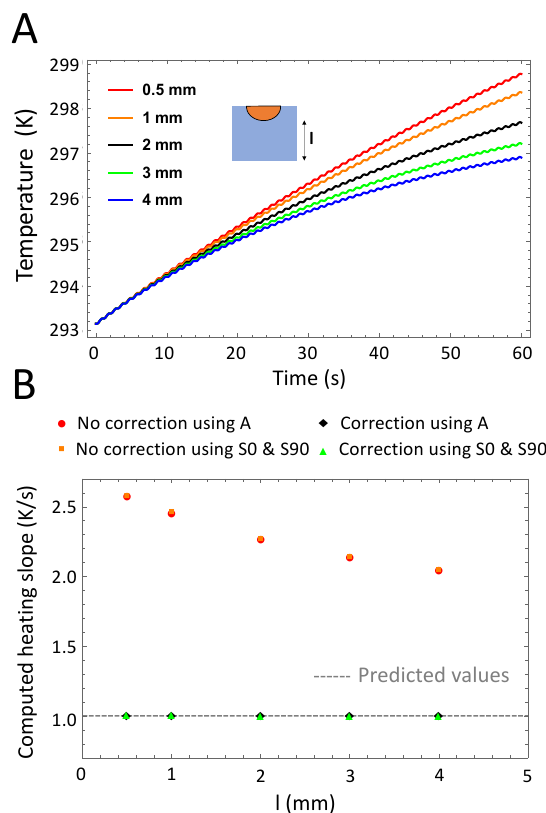
Figure 4. Variations of the sample holder thickness. ( A ): Time-dependent temperature of the sample for different sample holder thickness values l . For larger thickness, the signal reaches the quasi-steady state faster than for a thinner sample holder, for which the signal is still in the thermal relaxation phase after 60 s. ( B ): Computed heating slope β (normalized) for different sample holder thickness values. Heating slope calculations using the in-phase and in-quadrature signal or the amplitude signal alone lead to similar values. Correction of the thermal relaxation phase is required, in particular for thinner sample